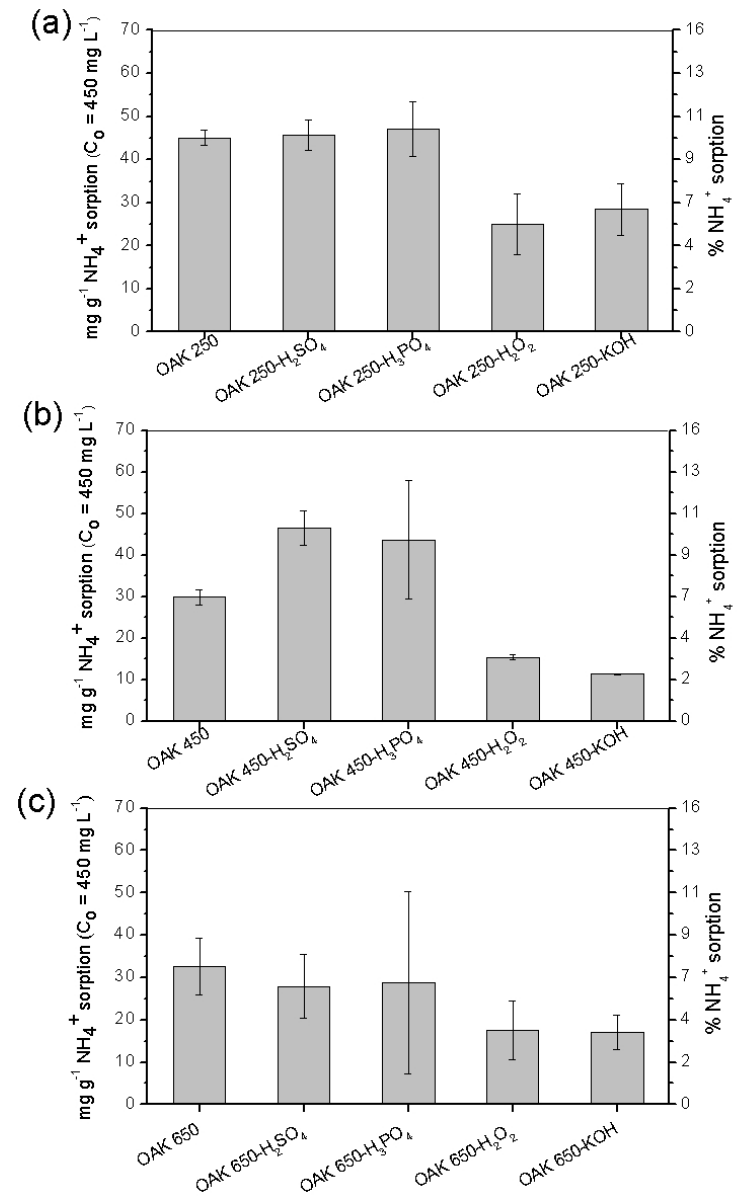
Figure 5. NH 4 + sorption by ( a ) treated Oak 250 hydrochar; ( b ) treated Oak 450 biochar; ( c ) treated Oak 650 biochar from 450 mg NH 4+ L − 1 solution. Based on duplicate data, error bars represent deviation around the